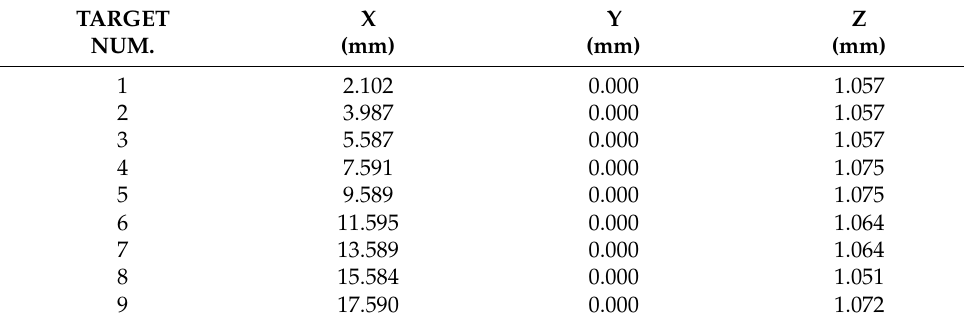
Table 2. Coordinates of the targets in the relative system.